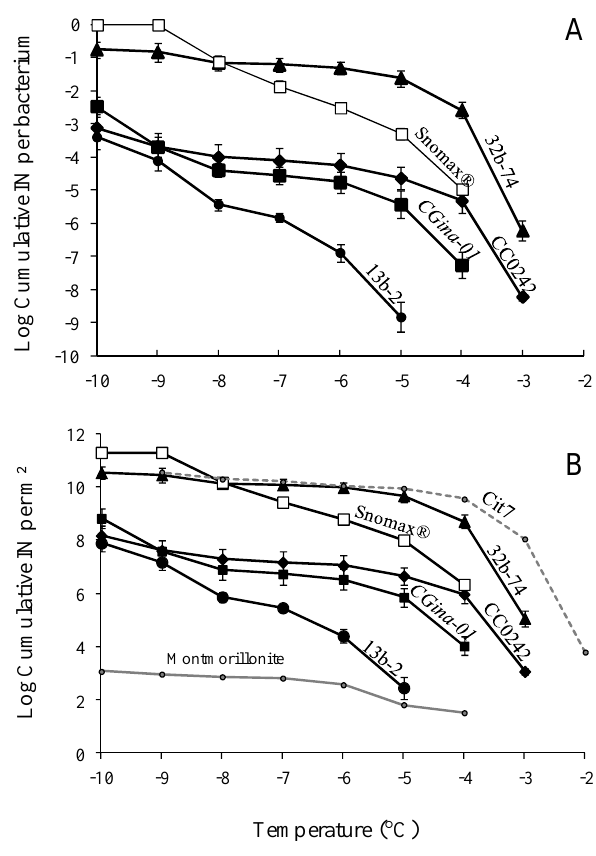
Fig. 1. Ice nucleation spectra of Pseudomonas strains in distilled Figure 1: Ice nucleation spectra of Pseudomonas strains in distilled water: P. syringae 32b-74 3 water: P. syringae 32b-74 N and 13b-2 • , P. syringae CC0242 (cid:7) , P. fluorescens CGina-01 (cid:4) , the commercial Snomax ▲ and 13b-2 (cid:1) , P. syringae CC0242 ♦ , P. fluorescens CGina-01 ■ , the commercial 4 Cit7 (grey dotted line; data from Orser et al., 1985) and Montmo- Snomax® □ , P. syringae Cit7 (grey dotted line; data from Orser et al., 1985) and 5 rillonite (grey solid line, data from Mortazavi et al., 2008). A: log Montmorillonite (grey solid line, data from Mortazavi et al., 2008). A: log (cumulative IN per 6 (cumulative IN per bacterium); B: log (cumulative IN per m 2 ). Er- rors bars indicate standard errors ( n = bacterium); B: log (cumulative IN per m²). Errors bars indicate standard errors (n=6). 7